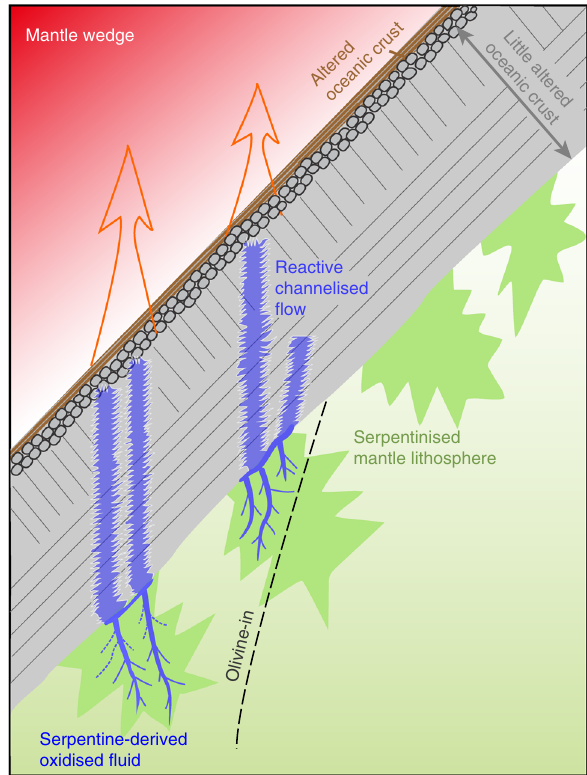
Fig. 4 Cartoon of Mo isotope behaviour in subduction zones. The sketch indicates oxidised fl uids from the dehydrating slab serpentine passing through the overlying oceanic crust, mobilizing Mo and leading to Mo isotopic fractionation. Resultant high δ 98/95 Mo NIST 3134 fl uids traverse into the hotter interior mantle wedge and induce melting. See text for